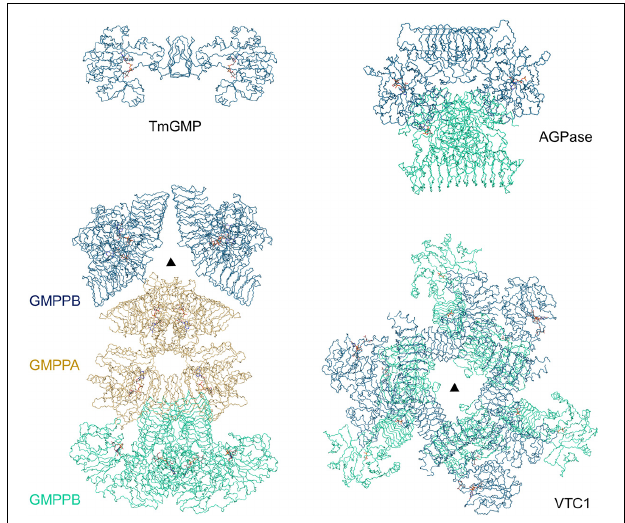
FIGURE 6 | Comparison of TmGMP, GMPPA-GMPPB, AGPase, and VTC1. The corresponding PDB entries are 2 × 5Z, 7D72, 1YP4, and 7 × 8K. The half GMPPA-GMPPB complex in a pseudo threefold symmetry is shown for comparison with the VTC1 dodecamer. TmGMP, two GMPPB dimers, two AGPase dimers, and three VTC1 dimers are shown in dark blue; GMPPA (di-dimer) is shown in dark yellow; two GMPPB dimers, two AGPase dimers, and three VTC1 dimers are in pale green. Triangle denotes the threefold symmetry